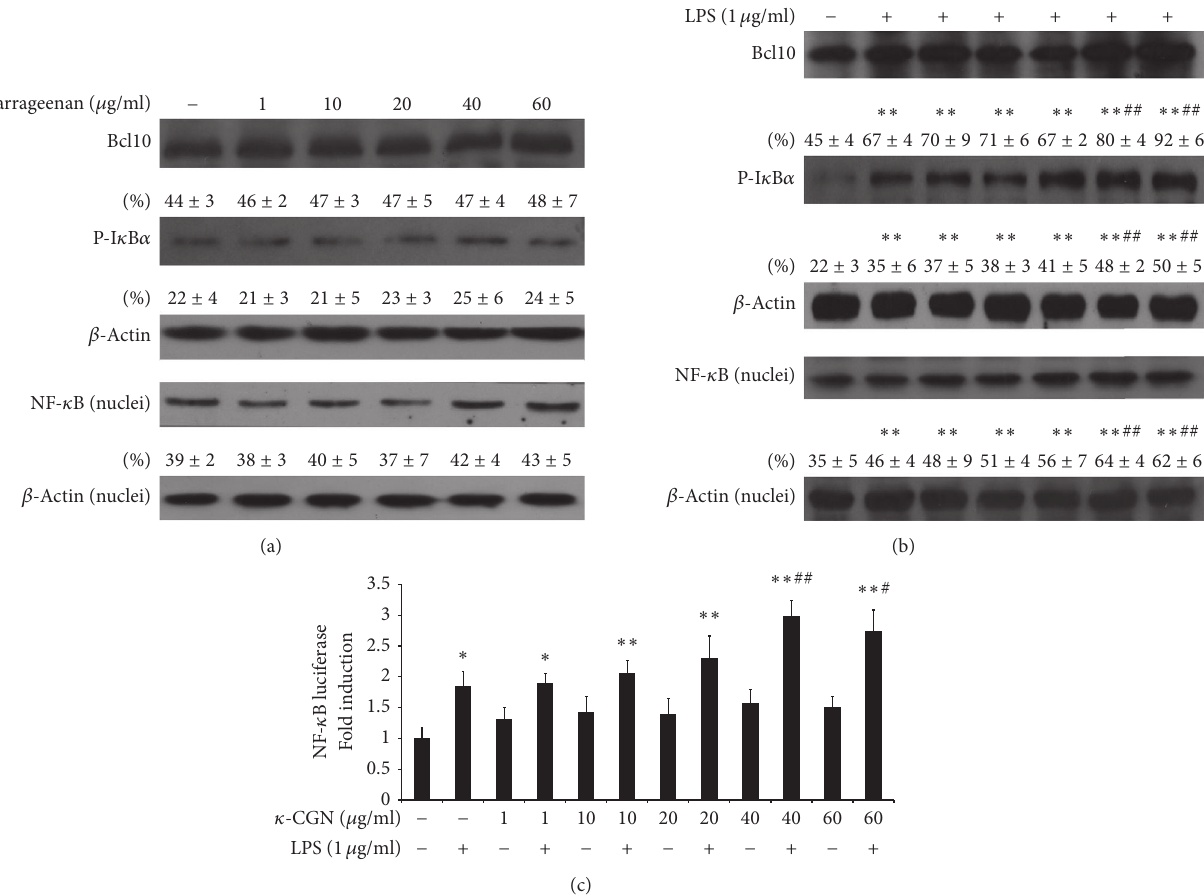
Figure 4: 𝜅 -Carrageenan potentiates the LPS-stimulated activation of NF- 𝜅 B. (a) The effect of 𝜅 -carrageenan on the expression of Bcl10, NF- 𝜅 B, and p-I 𝜅 B 𝛼 in HT-29 cells. (b) 𝜅 -Carrageenan enhances the LPS-stimulated secretion of Bcl10, NF- 𝜅 B, and p-I 𝜅 B 𝛼 . HT-29 cells were treated with 𝜅 -carrageenan for 1h. (c) 𝜅 -Carrageenan induces transcriptional activation of NF- 𝜅 B. ∗ 𝑃 < 0.05 , ∗∗ 𝑃 < 0.01 , compared with the blank group. # 𝑃 < 0.05 , ## 𝑃 < 0.01 , compared with the LPS treated